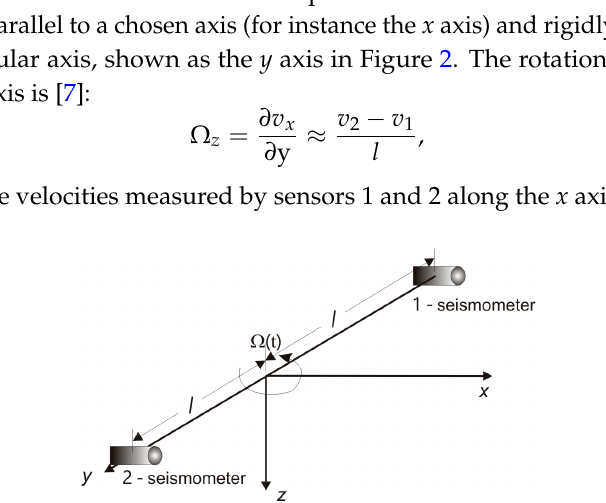
Figure 2. Principle of operation of a rotational seismometer for indirect measurement; sensors 1 and 2 are velocity seismometers. are velocity